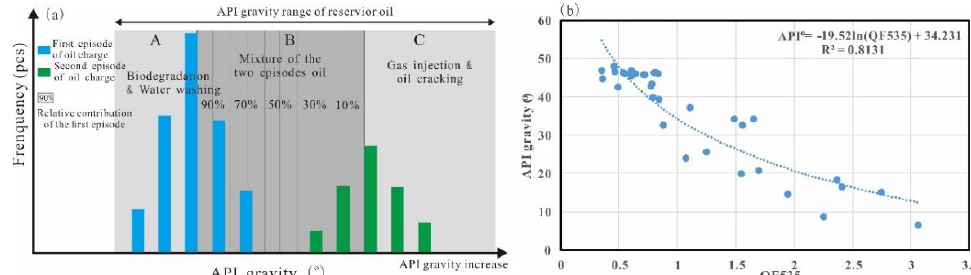
Figure 10. ( a ) The histogram of API gravity, fractional contribution of charged petroleum to present petroleum accumulation, and post-trapping alteration processes for two episodes of petroleum charge [43]; ( b ) the proper fitting function between API gravity and QF-535.